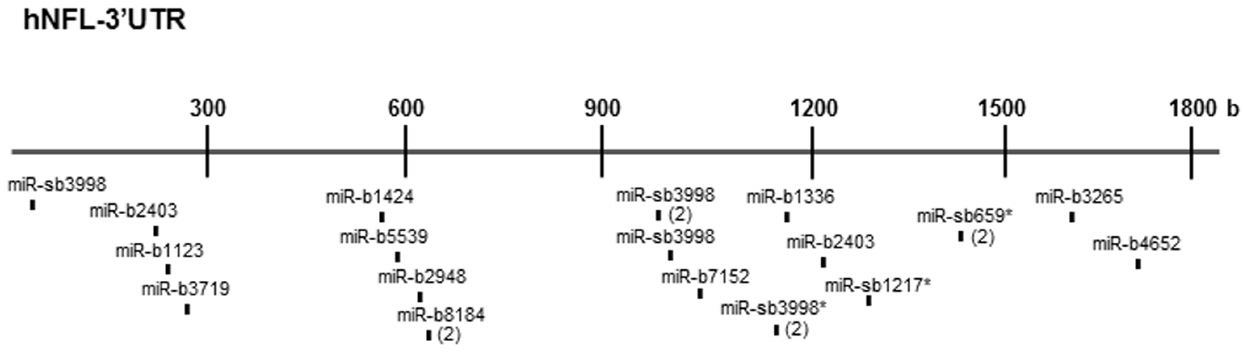
Figure 2. MiRNA response elements for the putative novel miRNAs in the NEFL mRNA 3 9 UTR. Note the presence of recognition sites for the many putative novel miRNAs throughout the 3 9 UTR. In addition, some miRNAs have more than one MRE in different positions within the NEFL mRNA 3 9 UTR (e.g. miR-b2403) and others have more than one MRE in overlapped positions within the NEFL mRNA 3 9 UTR (e.g. miR-b8184; number of MREs in